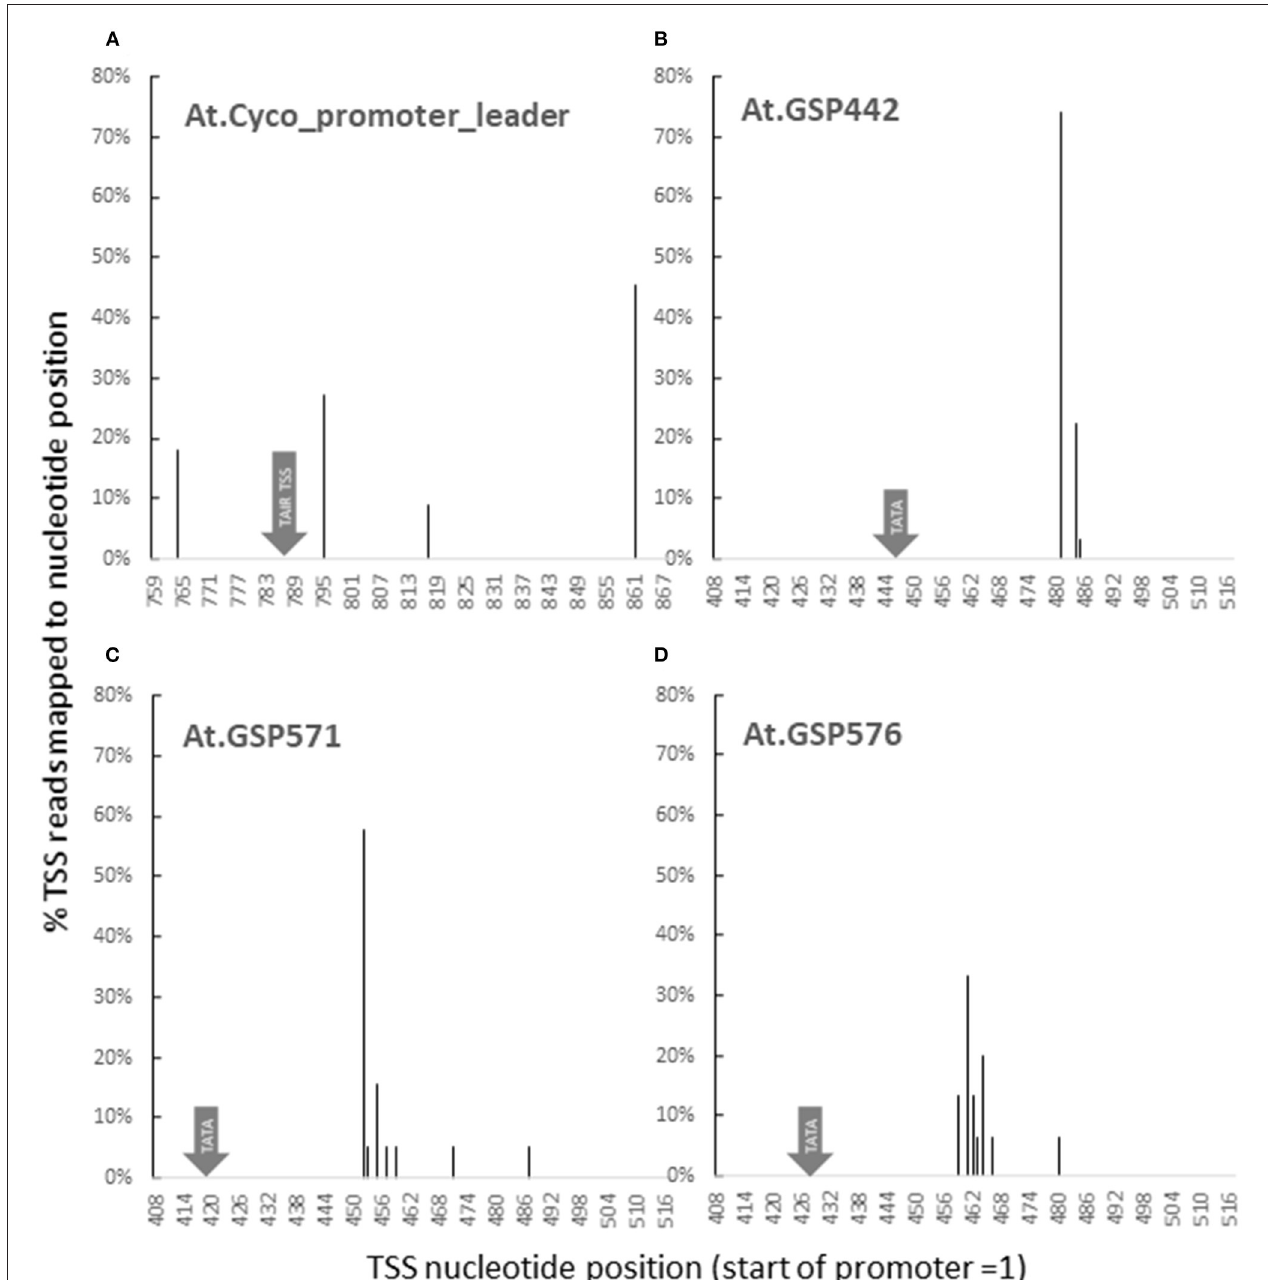
FIGURE 3 | GSPs initiate transcription as predicted. Transcription start sites (TSS) for GUS reporter genes driven by promoters and leaders from At.Cyco (A) , At.GSP442 (B) , At.GSP571 (C) , and At.GSP576 (D) were identified by 5 ′ RACE. 5 ′ ends of GUS cDNA fragments generated from leaf RNA were captured and sequenced. At least two independent transgenic events were characterized to produce > 20 reads. Sequencing reads were mapped to promoters to identify the TSS. The resulting sequencing reads were pooled to report the TSS distribution as % reads mapped to each nucleotide position. Nucleotide positions are reported with the 5 ′ most position of the promoter =